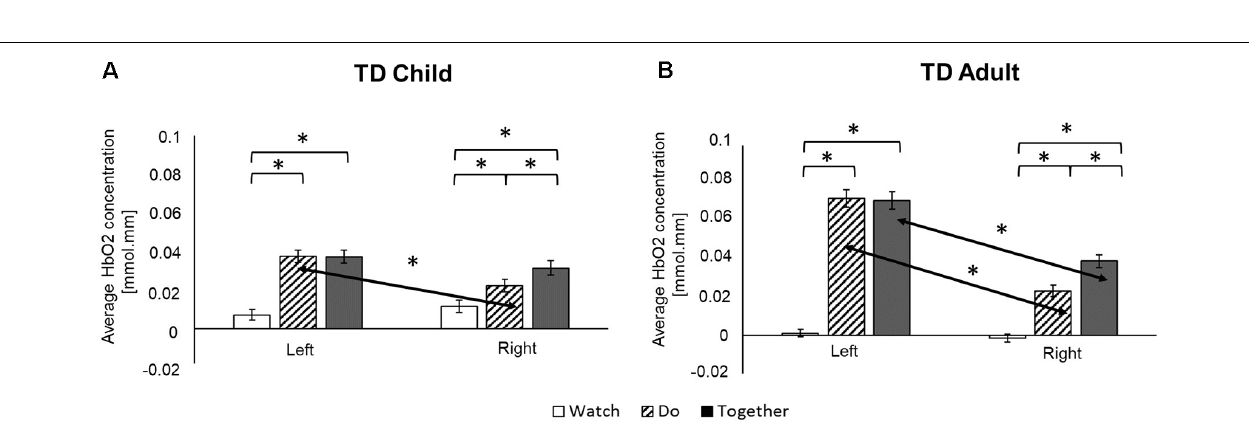
FIGURE 5 | Task-related and hemispheric differences for typically developing (TD) child (A) and adult (B) in average HbO 2 concentration. ∗ Indicates a significant difference. Arrows highlight hemispheric differences.